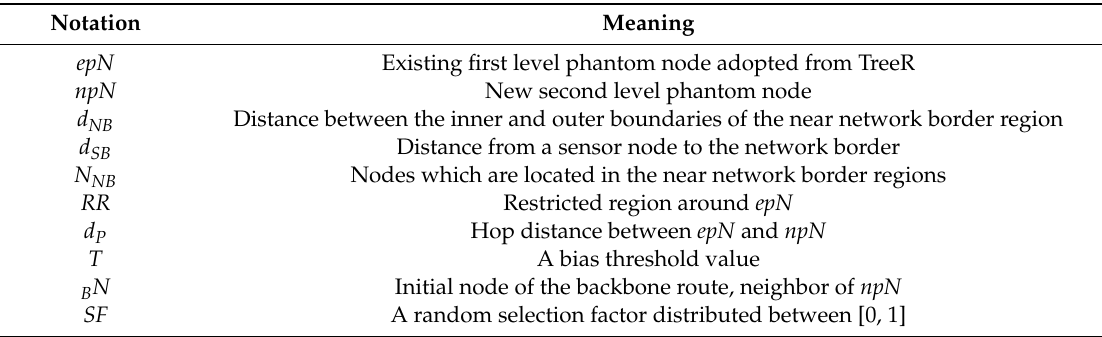
Table 5. Notations used in the proposed two-level phantom with a backbone route (PhaT)